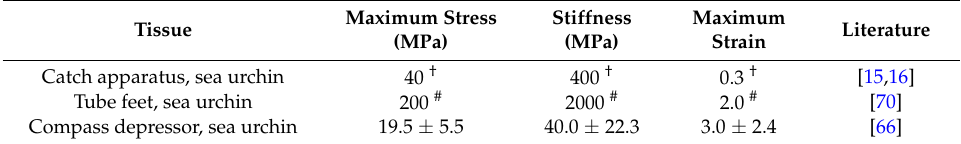
Table 1. Estimates of the values of the mechanical properties of tissues from the sea